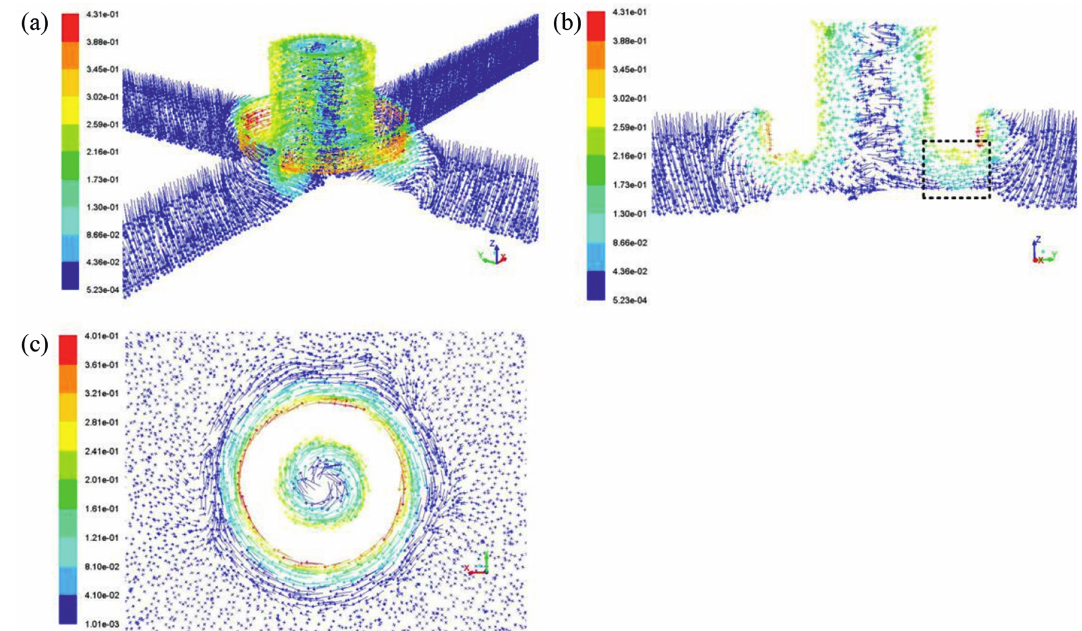
Figure 7: Material flow behavior at the refilling stage (1,000rpm and 4mm/s): (a) three-dimensional, (b) section a and (c) section b.